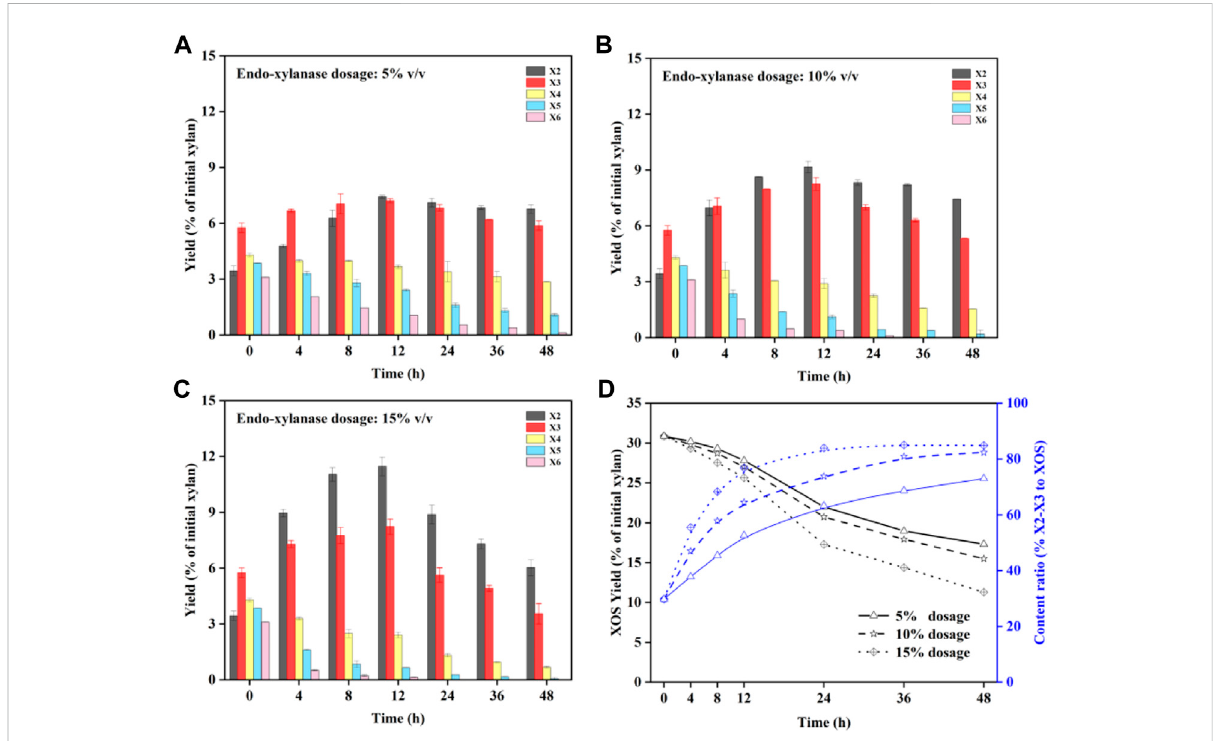
FIGURE 3 Distribution of X2 – X6 during enzymatic hydrolysis with different enzyme dosages: 5% (A) ; 10% (B) ; 15% (C) ; concentration of X2 – X3 and X2 – X3 proportion of XOS (D) .